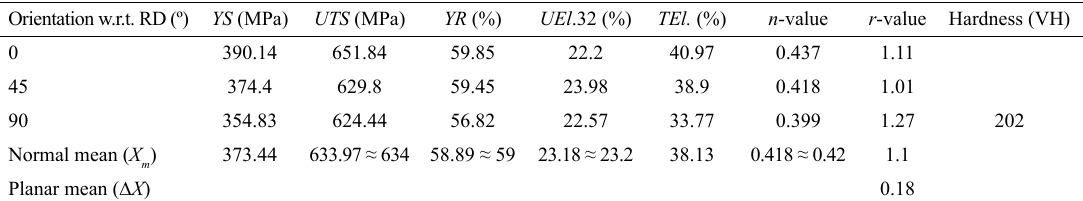
Table 3. Tensile properties and formability characteristics of Al-killed AISI 1040 steel strips in heat treated condition. Orientation w.r.t. RD (º) YS